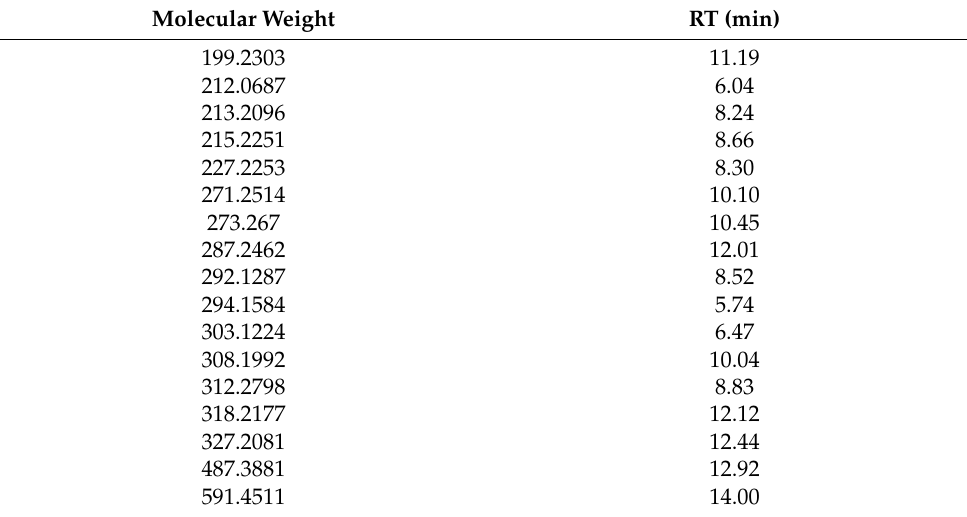
Table 3. Features detected in ‘unknown search’ after filtering. Molecular weight and retention time (RT) (min).